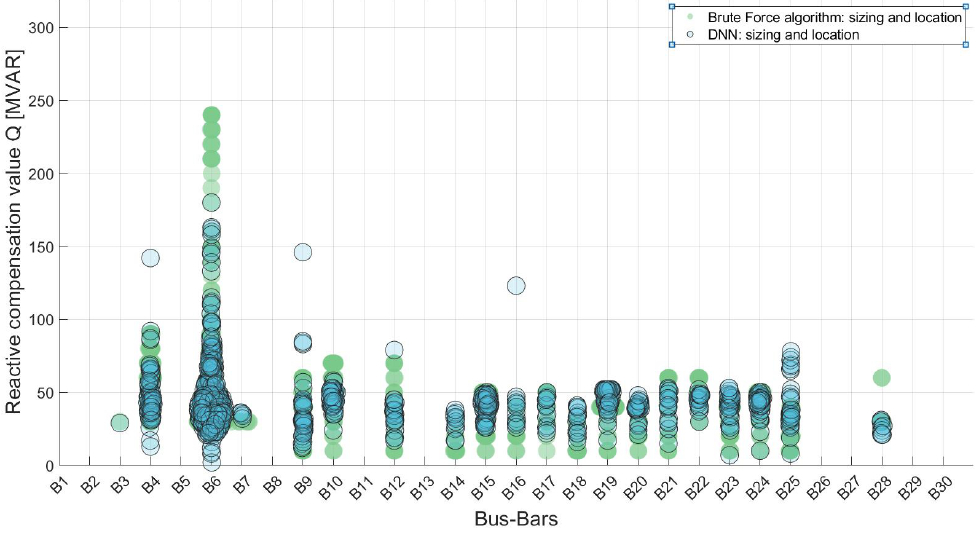
Figure 7. Sizing and location results: DNN vs. brute force algorithm—IEEE 30